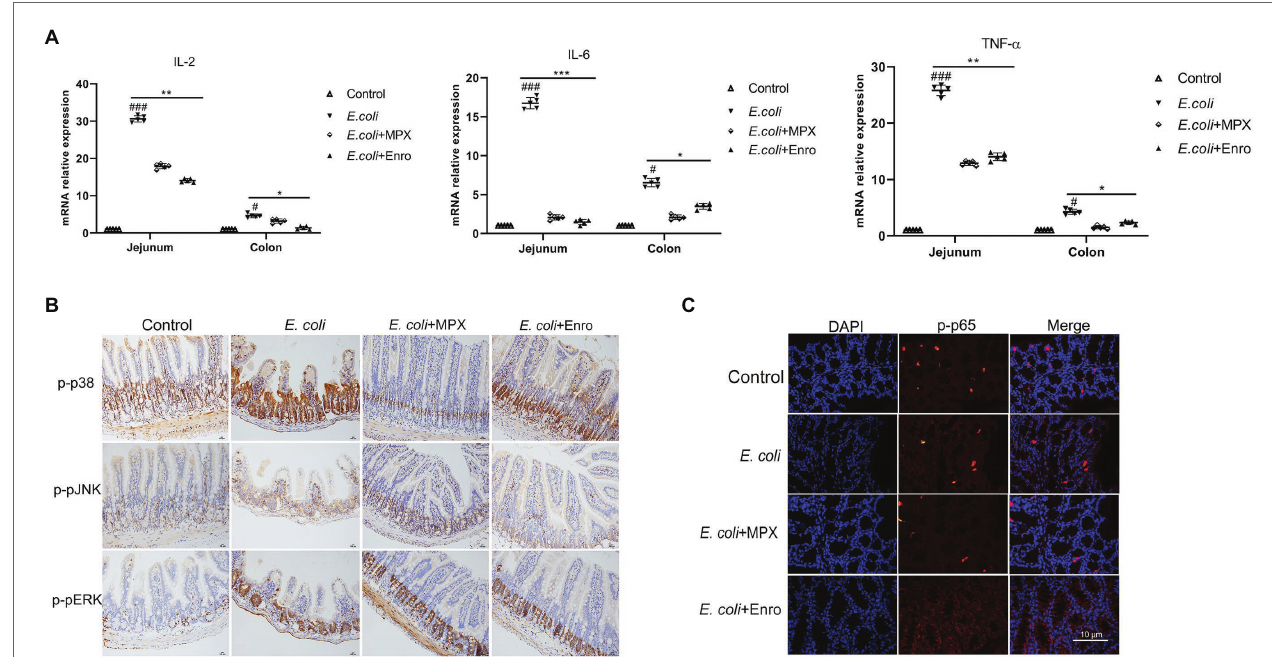
FIGURE 6 | MPX suppresses intestinal inflammation by inhibiting the activation of the MAPK and P65 signaling pathways. (A) The mRNA expression of IL-2, IL-6, and TNF- α in the jejunum and colon after MPX treatment was measured by real-time PCR. (B) The expression of p-p38, p-pJNK and p-pERK in the jejunum after MPX treatment was determined by immunohistochemistry (bars, 100 μm). (C) The effect of MPX on the expression of p-p65 in the colon was assessed by immunofluorescence. Error bars represent mean ± SEM, n = 5. Statistical significance was defined as follows: # P < 0.05; ## P < 0.01; ### P < 0.001 E. coli vs control; * P < 0.05; ** P < 0.01; *** P < 0.001 MPX and Enro treatment vs E. coli